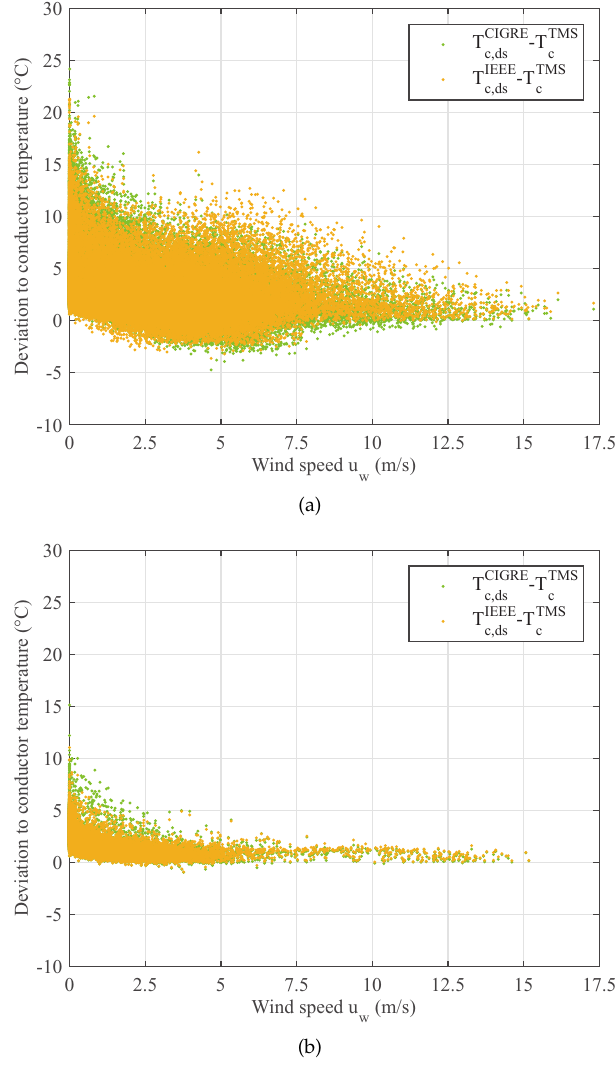
Figure 6. Deviation of conductor temperature obtained using CIGRE ( T CIGRE standards to the measured conductor temperature ( T TMS c ) vs. wind speed for an entire year. ( a ) For all data; ( b ) Q s = 0 W / m 2 , T TMS